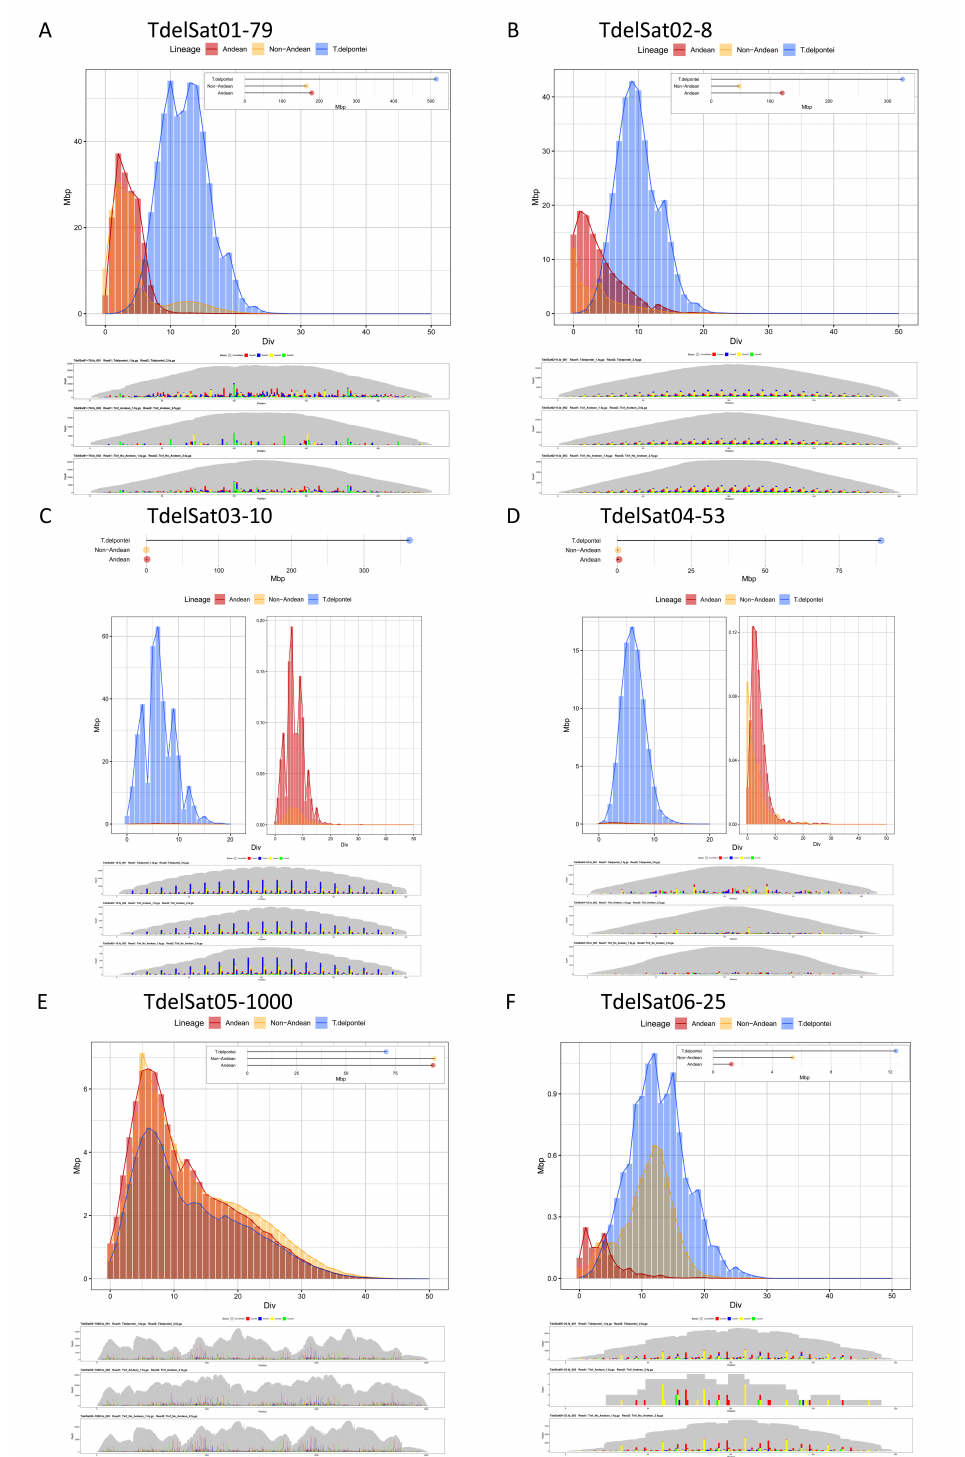
Figure 4. Results of the most abundant satDNAs in T. delpontei , Andean and non-Andean T. infestans lineages: ( A ) TdelSat01-79, ( B ) TdelSat02-8, ( C ) TdelSat03-10, ( D ) TdelSat04-53, ( E ) TdelSat05-1000 and ( F ) TdelSat06-25. Above: satellite abundance (Mb) estimated by RepeatMasker using each species consensus in the three analyzed genomes, and satellite DNA landscape graphics (abundance in Mb vs. divergence in percentage). Each calculation was performed as above using each species’ consensus over their own genome reads. Bottom: RepeatProfiler variation analyses over the three genomes analyzed. The consensus sequences of T. delpontei were